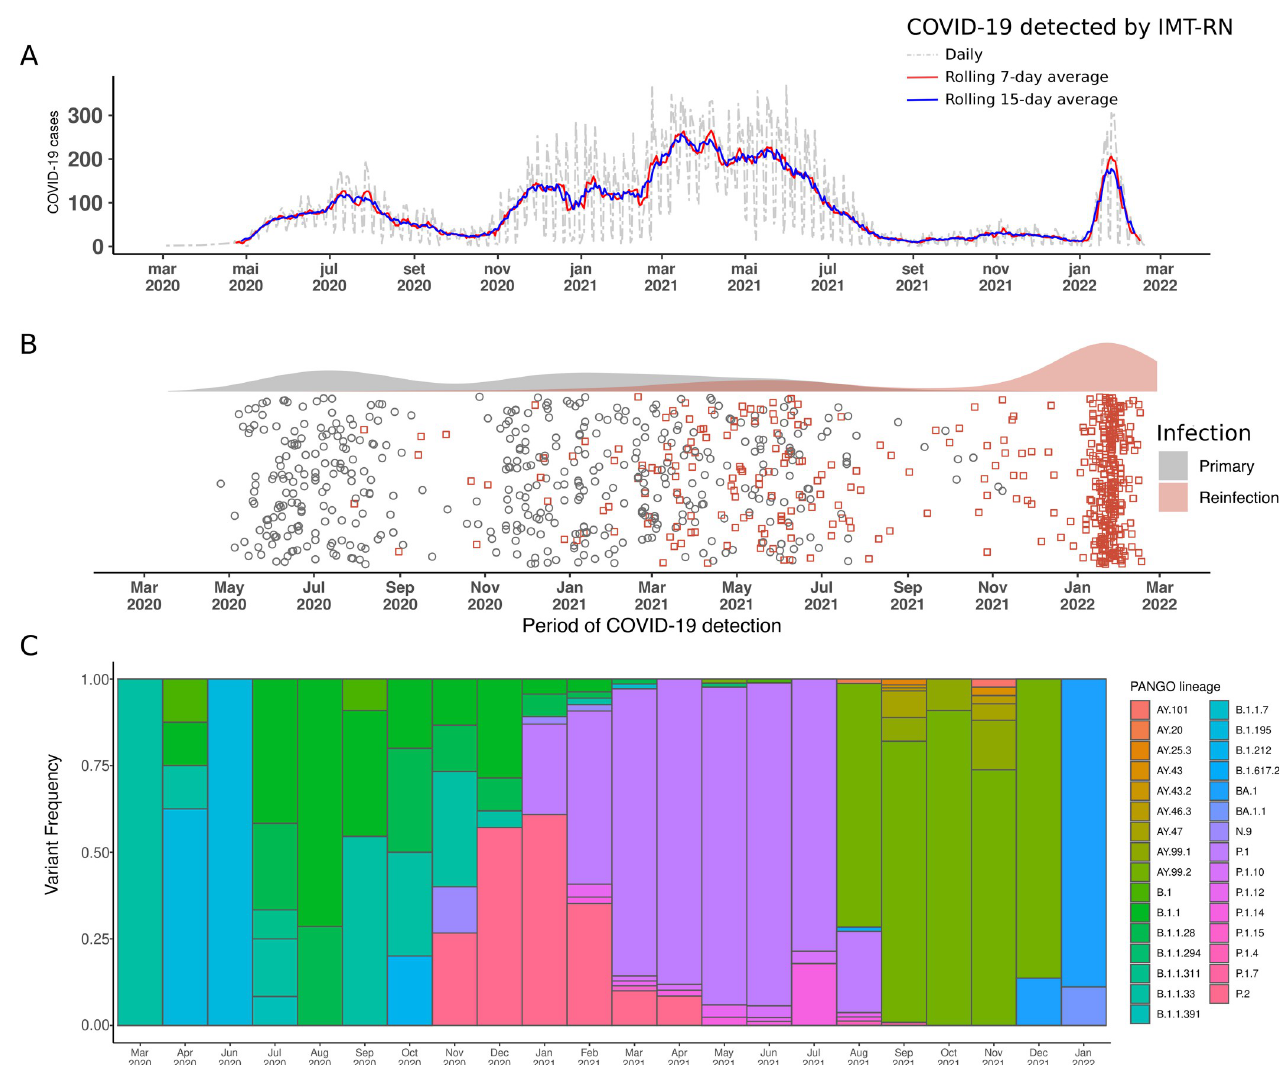
Fig 1. Timeline of COVID-19 detection cases in Rio Grande do Norte state, Brazil. (A) Positive COVID-19 cases in RN detected by RT-qPCR in IMT-RN laboratory. (B) Detection of SARS-CoV-2 reinfection in 444 individuals. Participants with two entries were identified and the first (gray circle) and second (red square) entries were plotted. A gray line connects both COVID-19 tests for the same individual. The density of COVID-19 cases on top of the plot. (C) SARS-CoV-2 PANGO lineages sequenced in the state from March 2020 to January 2022, obtained from